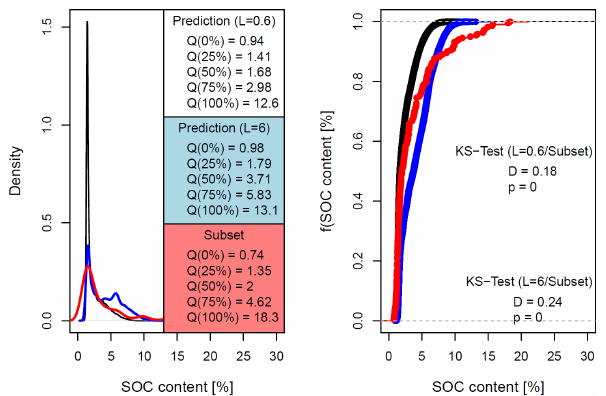
Figure 10. Comparison of soil samples’ (red) and predicted SOC content (%) distributions (black/blue): density plots with quantile values Q ( left ) and plots of empirical cumulative distribution functions (ECDF) with Kolmogorov–Smirnov (KS) distances D ( right ) for two prediction variants.